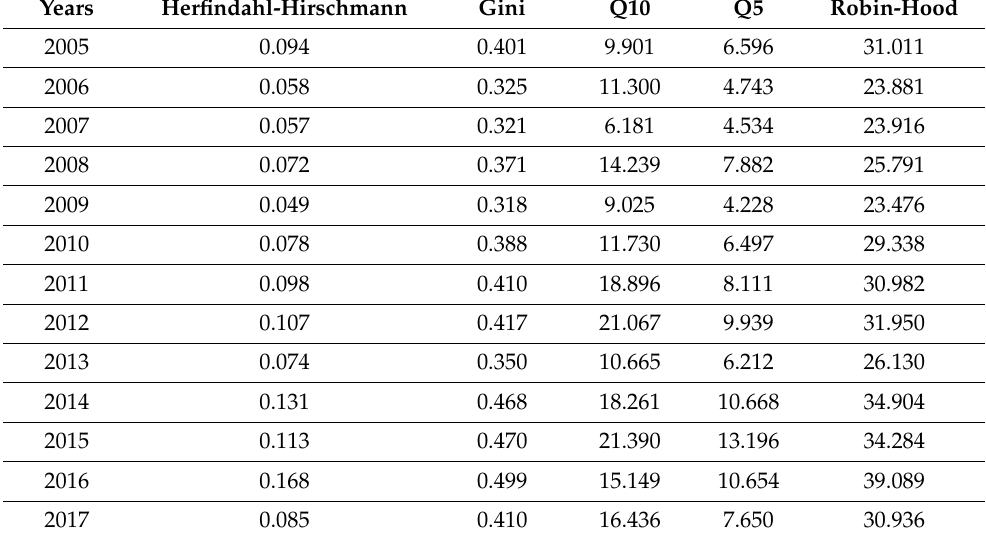
Table 6. Changes in sports expenditure inequality indices between 2005 and 2017, all households. Years Herfindahl-Hirschmann